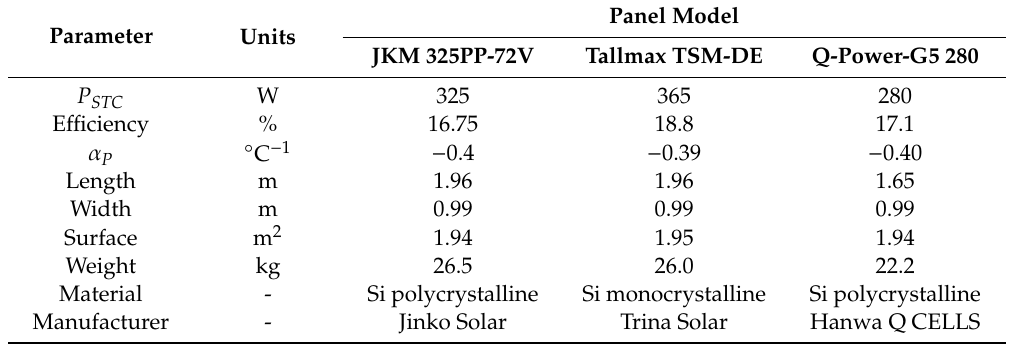
Table 2. Technical specifications of the solar photovoltaic (PV) panels considered (data source: [49–51]). Panel Model Parameter Units JKM 325PP-72V Tallmax TSM-DE Q-Power-G5 280 P STC W 325 365 280 E ffi ciency % 16.75 18.8 17.1 ◦ C − 1 − 0.4 − 0.39 − 0.40 α P Length m 1.96 1.96 1.65 Width m 0.99 0.99 0.99 Surface m 2 1.94 1.95 1.94 Weight kg 26.5 26.0 22.2 Material - Si polycrystalline Si monocrystalline Si polycrystalline Manufacturer - Jinko Solar Trina Solar Hanwa Q